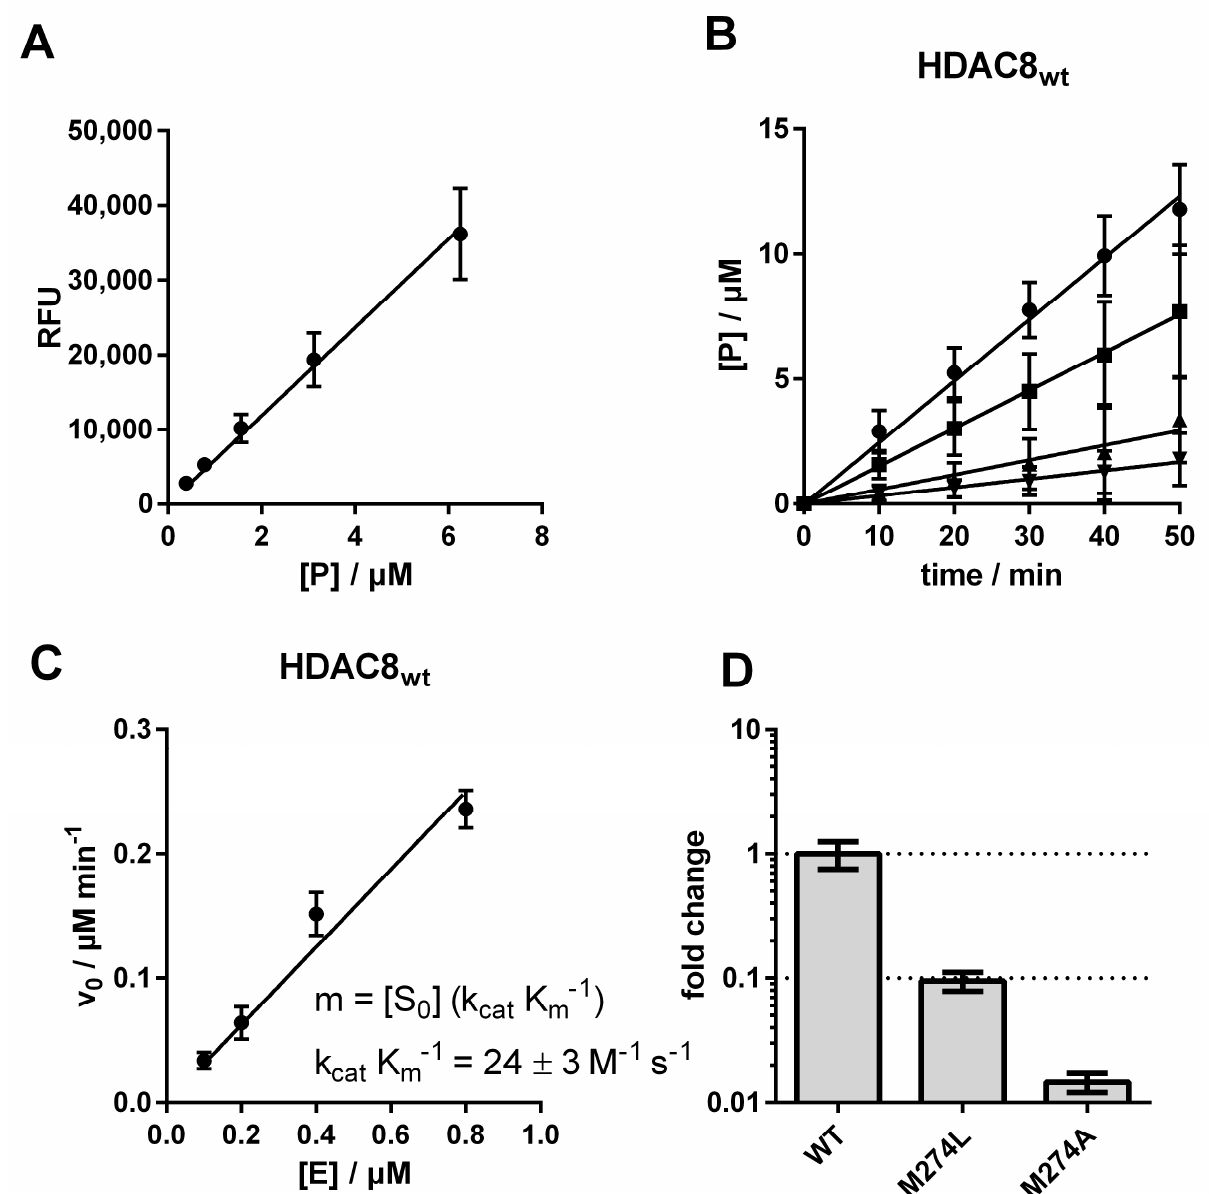
Figure 3. Determination of catalytic efficiencies for HDAC8. ( A ) Product calibration using free AMC. ( B ) Progress curves for the conversion of 200 μ M of the artificial substrate Boc-Lys(Ac)-AMC by ● 0.8 μ M, ■ 0.4 μ M, ▲ 0.2 μ M, and ▼ 0.1 μ M HDAC8 wt . ( C ) Plot of initial velocity against enzyme concentration. ( D ) Comparison of the catalytic efficiencies. Data show mean values and standard deviations, n ≥ 3.